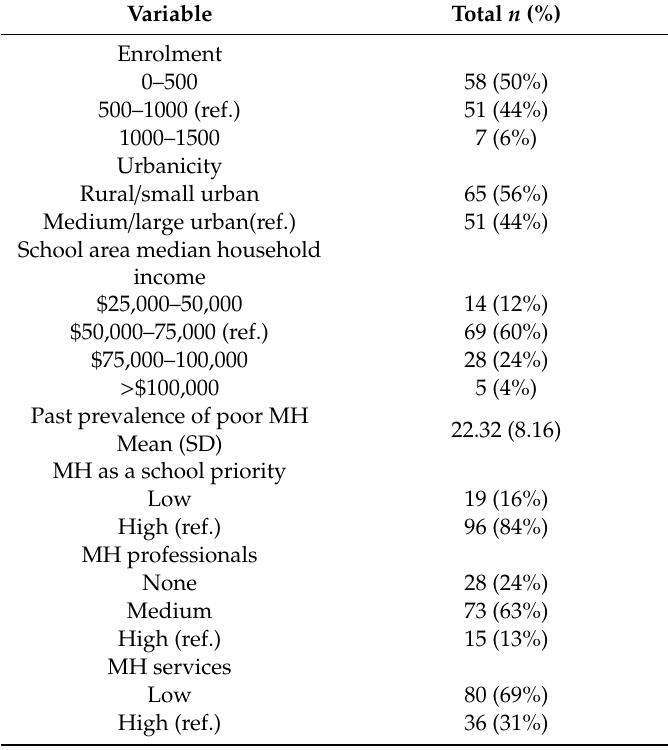
Table 2. School characteristics of the schools participating in Year 6 and 7 (2017–2018, 2018–2019) of the COMPASS Study in Canada ( n =